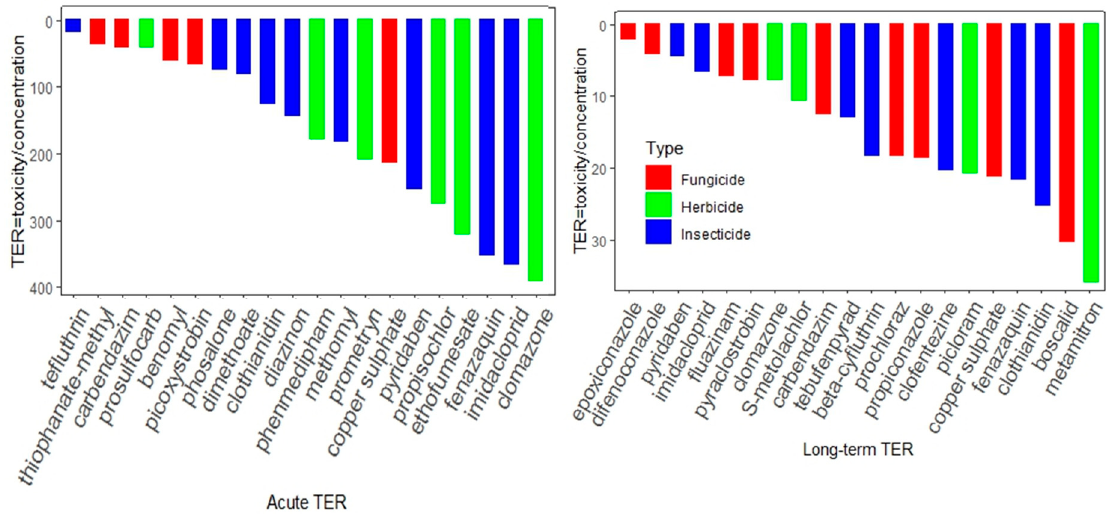
/ long-term TER for earthworms. Figure 11. Ratings of the acute/long-term TER for earthworms. Figure 11. Ratings of the acute